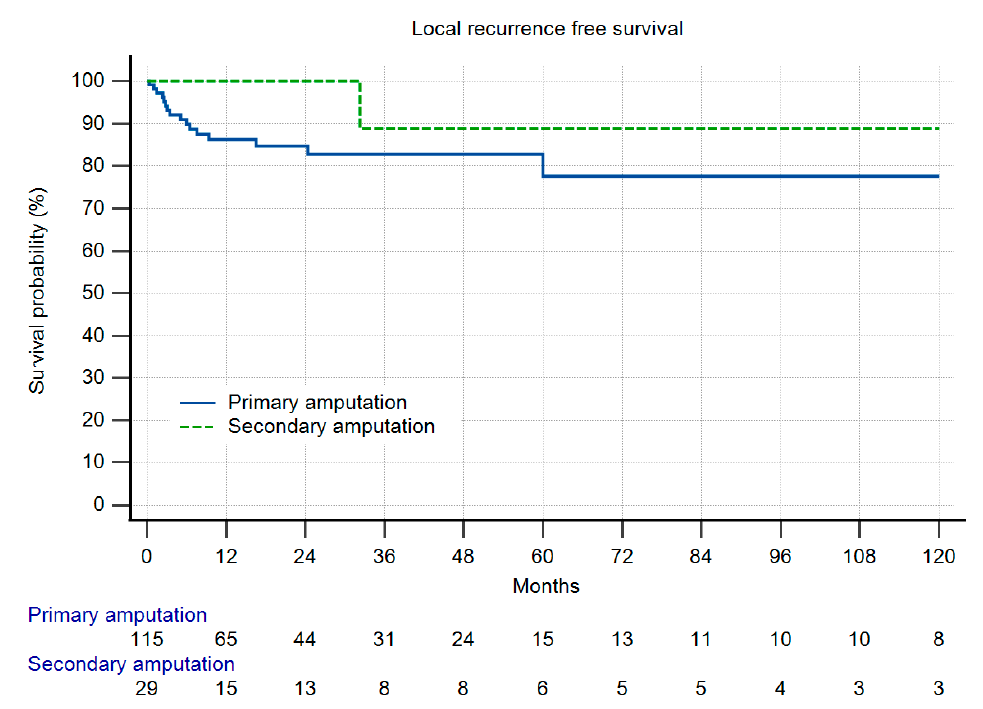
Figure 5. Local recurrence-free survival (LRFS) in 144 patients with primary or secondary amputations (five patients excluded due to insufficient data), n.s.